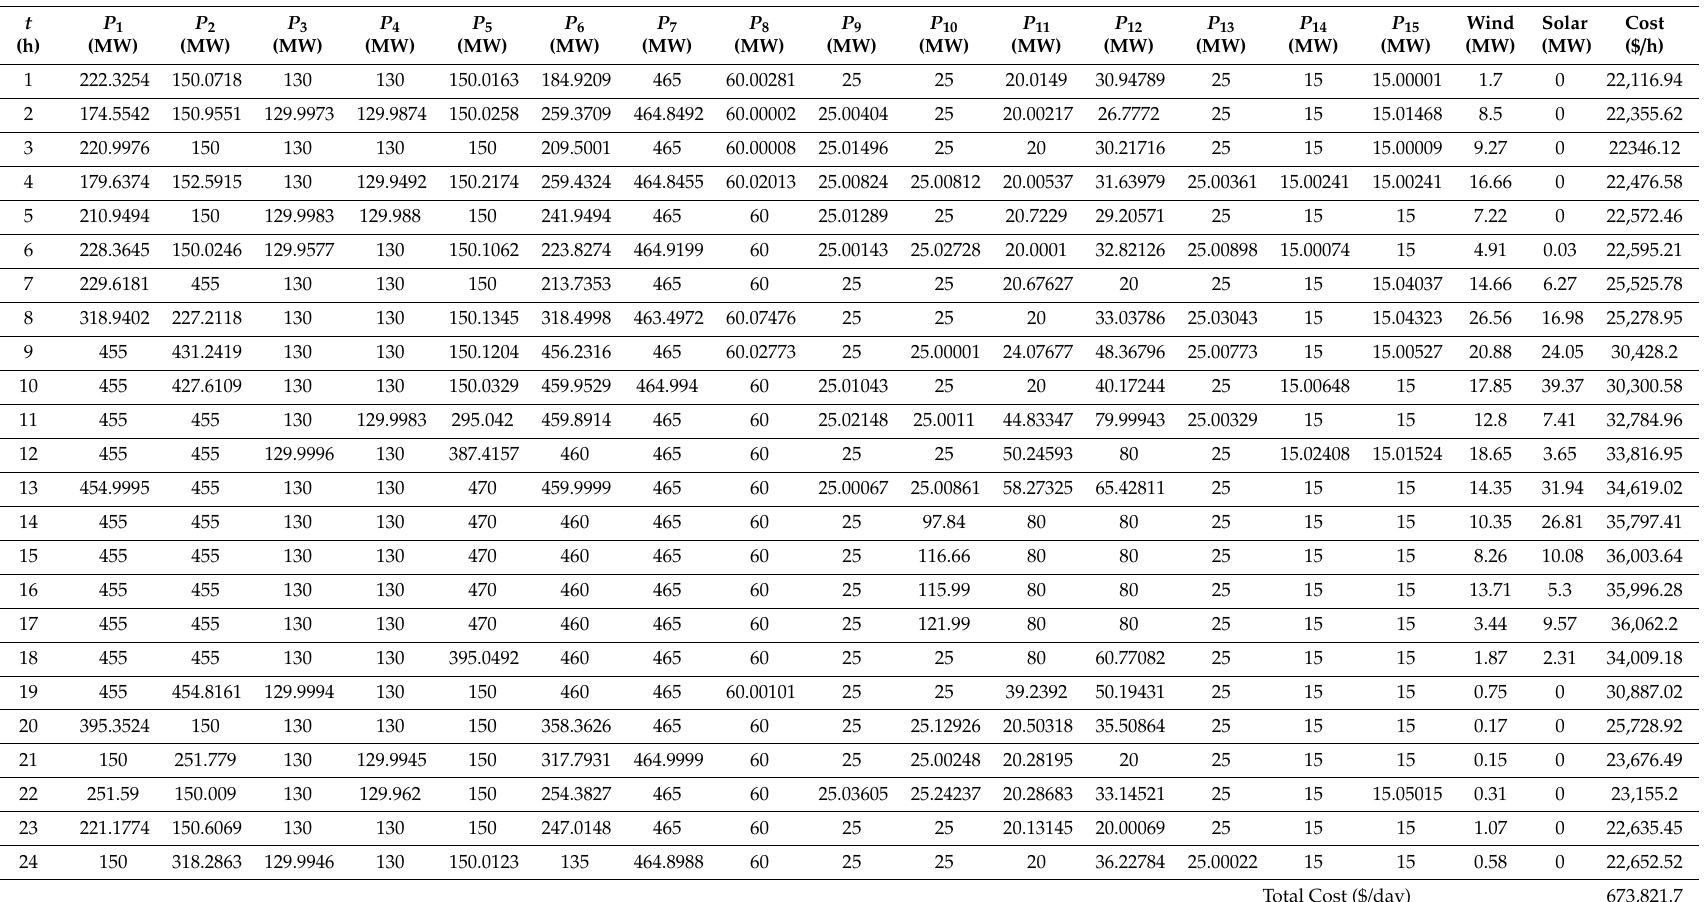
Table 12. The dBA on a 15-unit system with